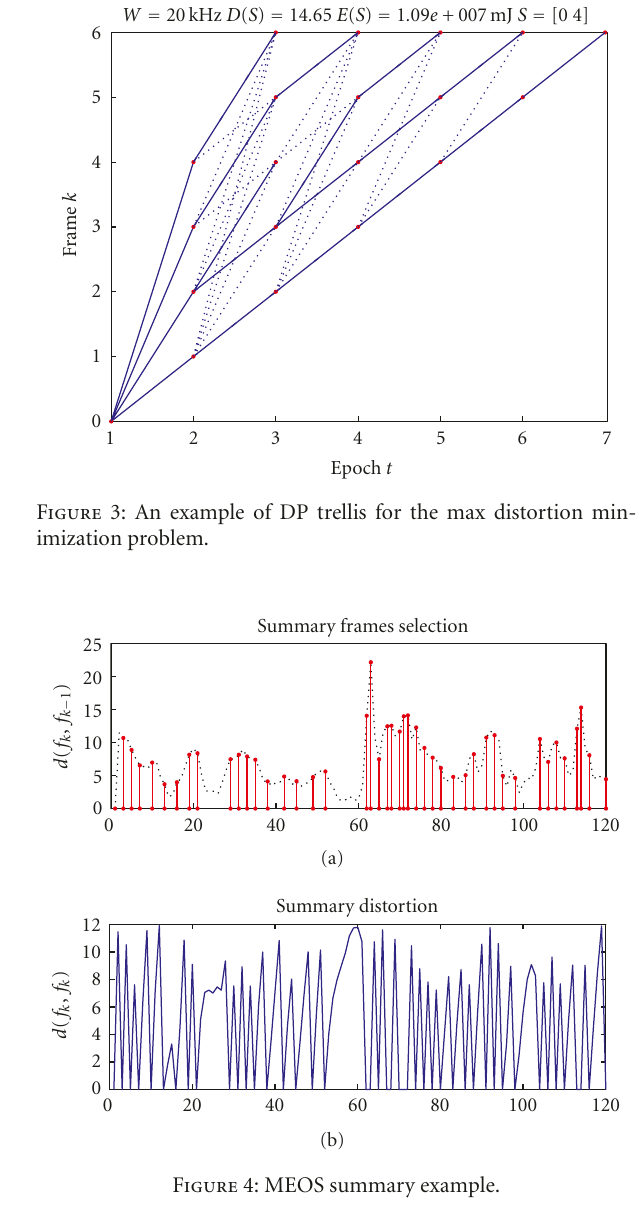
distortion threshold D max = 12, and the resulting summary consists of 45 frames. Figure 4(a) is the sequence activity level profile as di ff er- ential frame distance, d ( f k , f k − 1 ), and the summary frame selections are plotted in red vertical lines. Figure 4(b) is the ). Notice that the placement summary distortion plot d ( f k , f (cid:5) k of summary frames brings the maximum distortion for each segment below D max indeed. The density of the summary frames also reflects well the activity level in the sequence, as